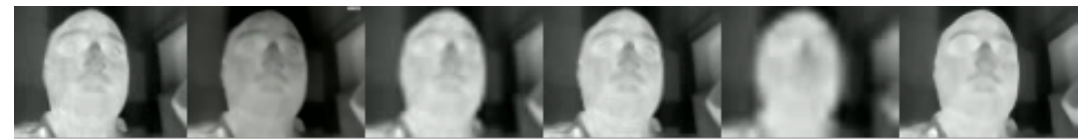
Figure 6. The corresponding frame extracted from the Lepton 8-bit sequences used in the study for respiratory rate evaluation. From the left: original, Eulerian Video Magnification, bicubic interpolation scale 2, super resolved using our model scale 2, bicubic interpolation scale 4, super resolved using our model scale 4.